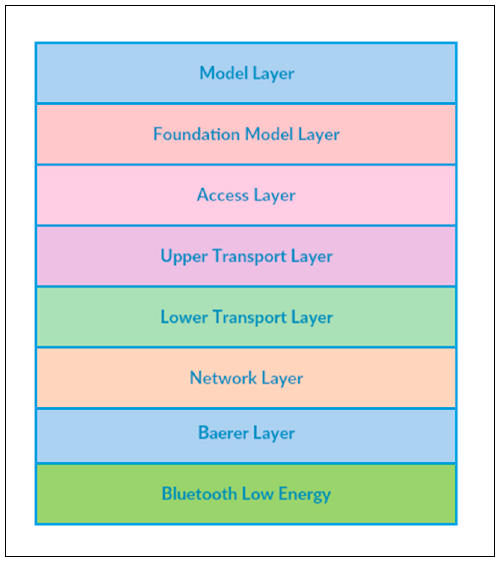
Figure 7. Bluetooth mesh stack [11].